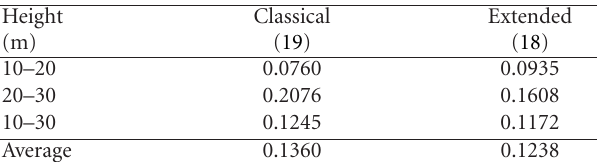
Table 3: Exponent calculations both classical and extended power